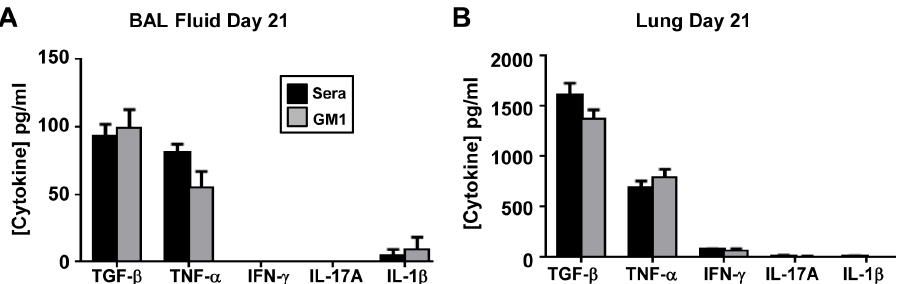
Figure 6. BAL fluid and lung cytokine levels on day 21 post-bleomycin injection. IL-1 b , TGF- b , TNF- a , IFN- c , IL-17A levels were measured by ELISA in ( A ) BAL fluid or in ( B ) lung homogenates from mice treated with control sera control or anti-asialo GM1. Mean 6 SEM of n=7–10 mice per